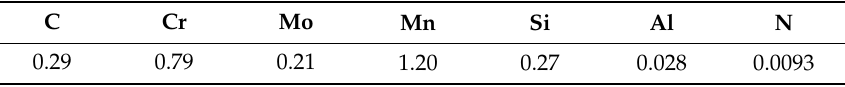
Table 1. Chemical composition of the investigated Cr-Mo low-alloyed steel in